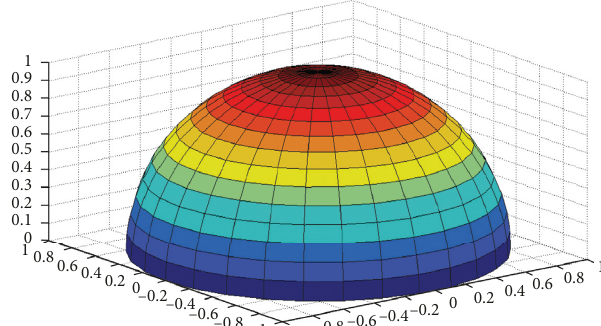
Figure 4: A hemisphere model with a radius of 1m.